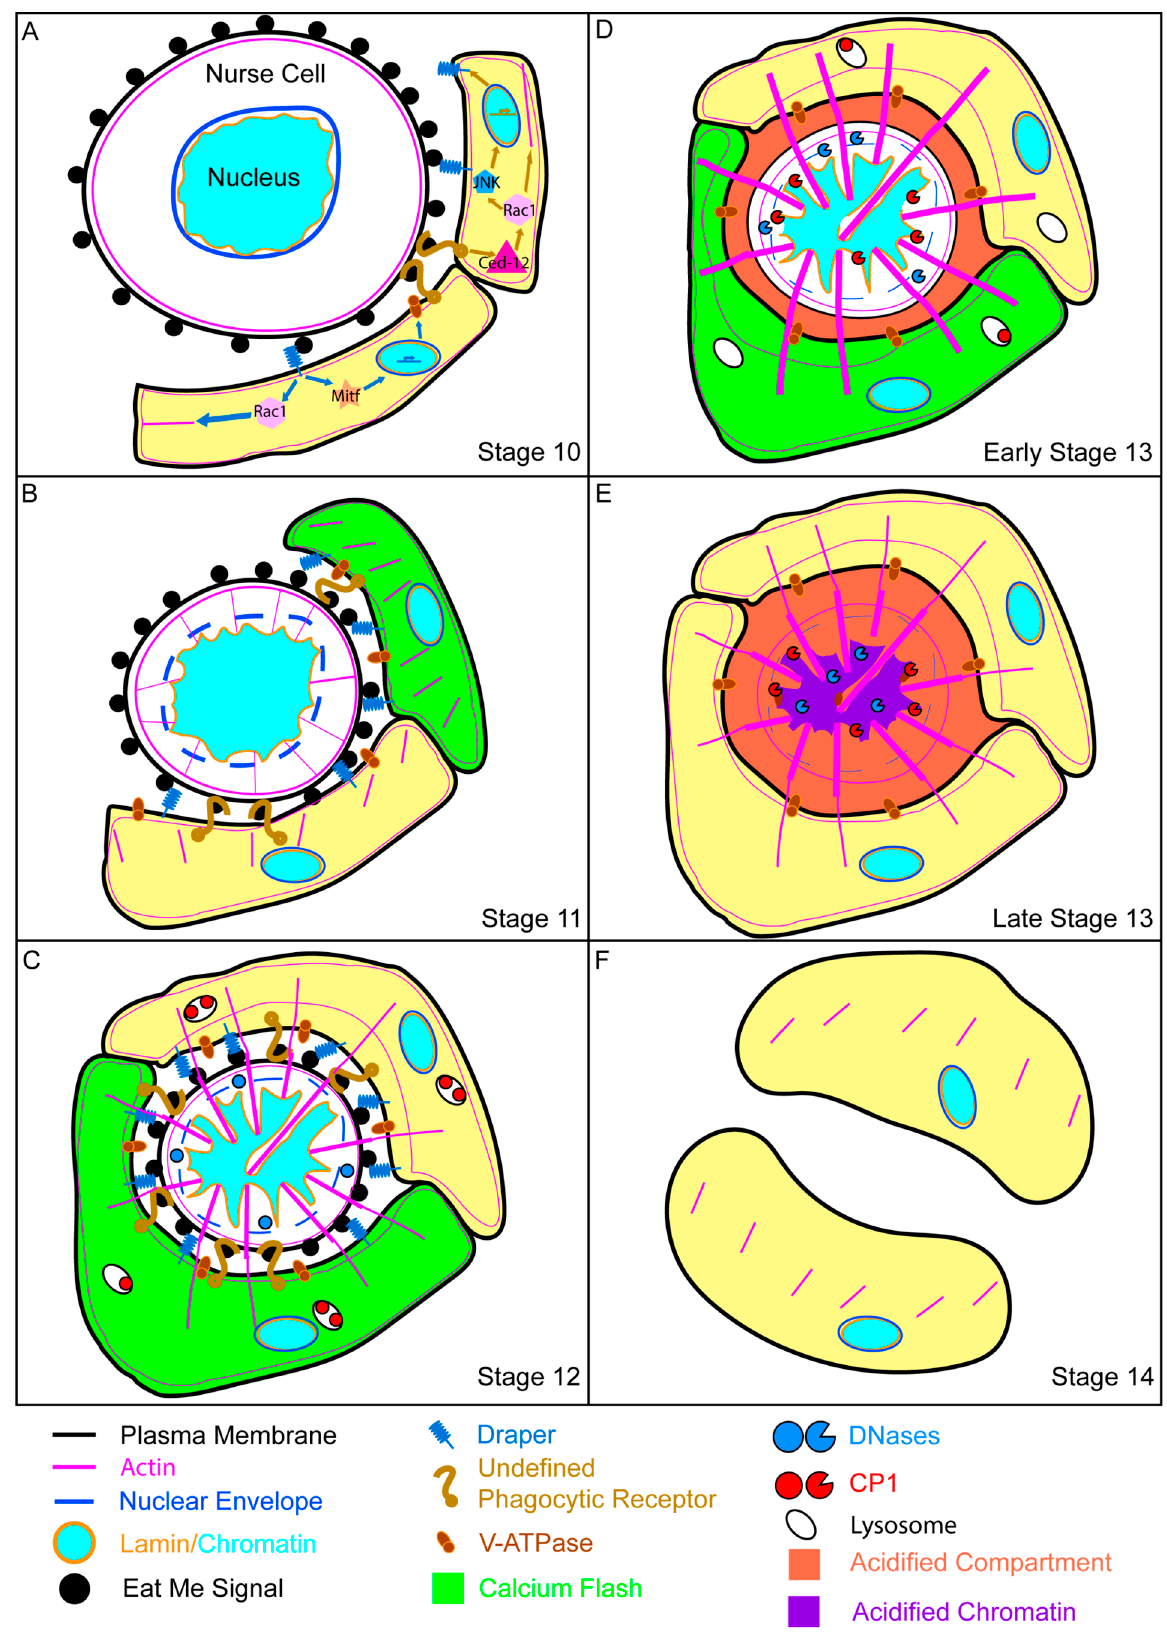
Figure 5. A model of developmental death and clearance of the nurse cells. ( A ) NCs of stage 10 egg chambers are at the cusp of death. The NC nucleus is already starting to fold, but the only visible actin is cortical. The NC has exposed a